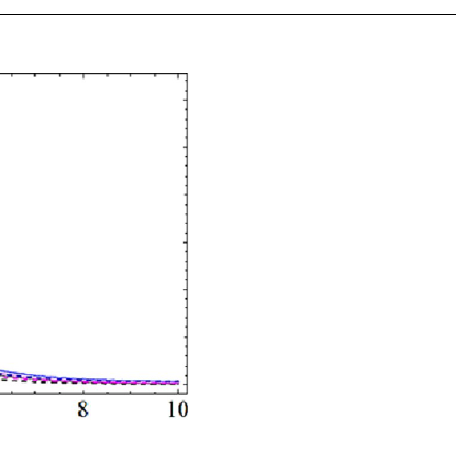
Fig 7. Thermal characteristics for different values of CuO volume fraction.